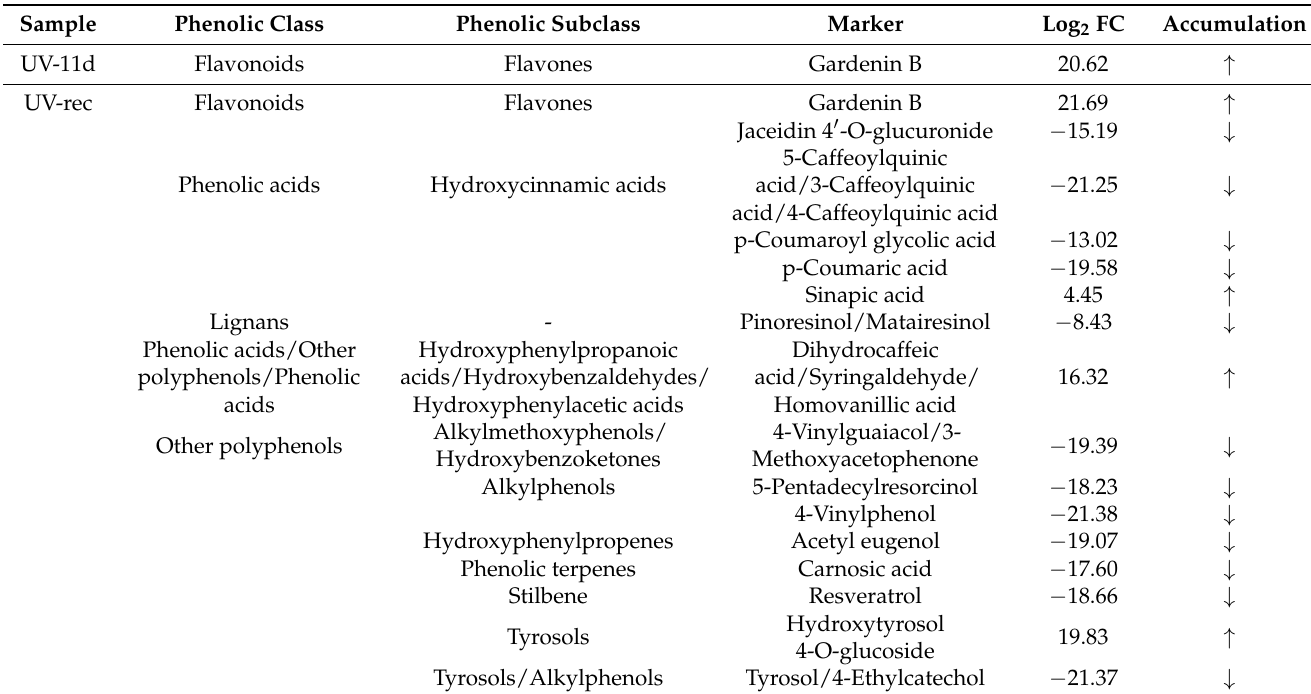
Table 6. List of the phenolic compounds in UV-treated roots, selected by combining analysis of variance and fold-change into volcano plot (Benjamini–Hochberg multiple testing correction, p < 0.05; fold-change cut-off = 1.2). The symbols “ ↑ ” and “ ↓ ” mean increased and decreased accumulation,